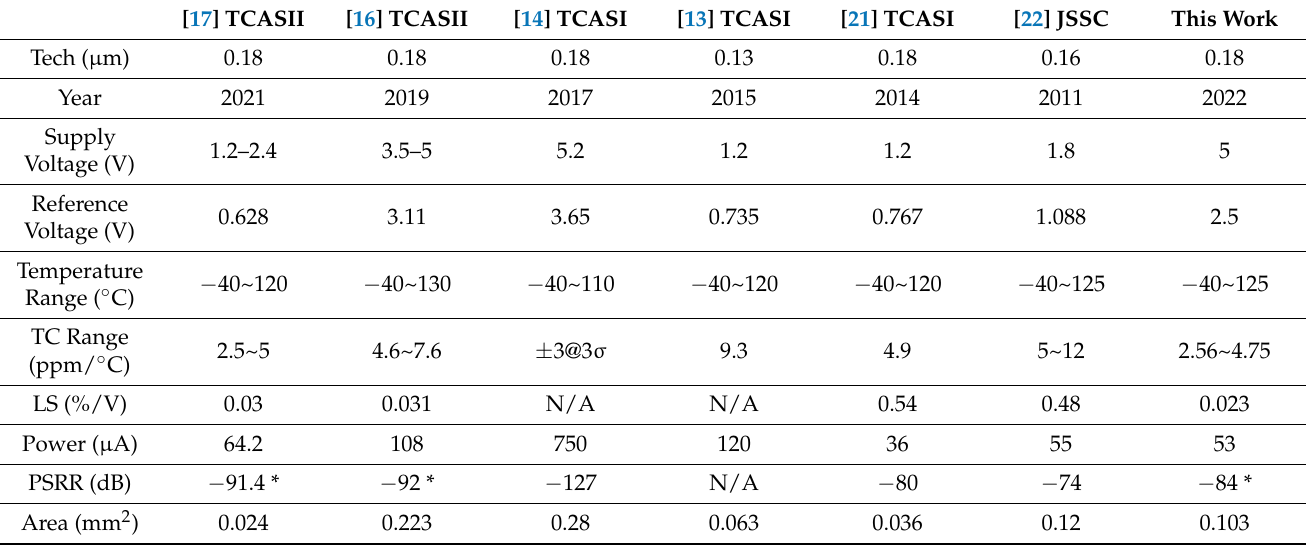
Table 1. Performance summary and comparison with other